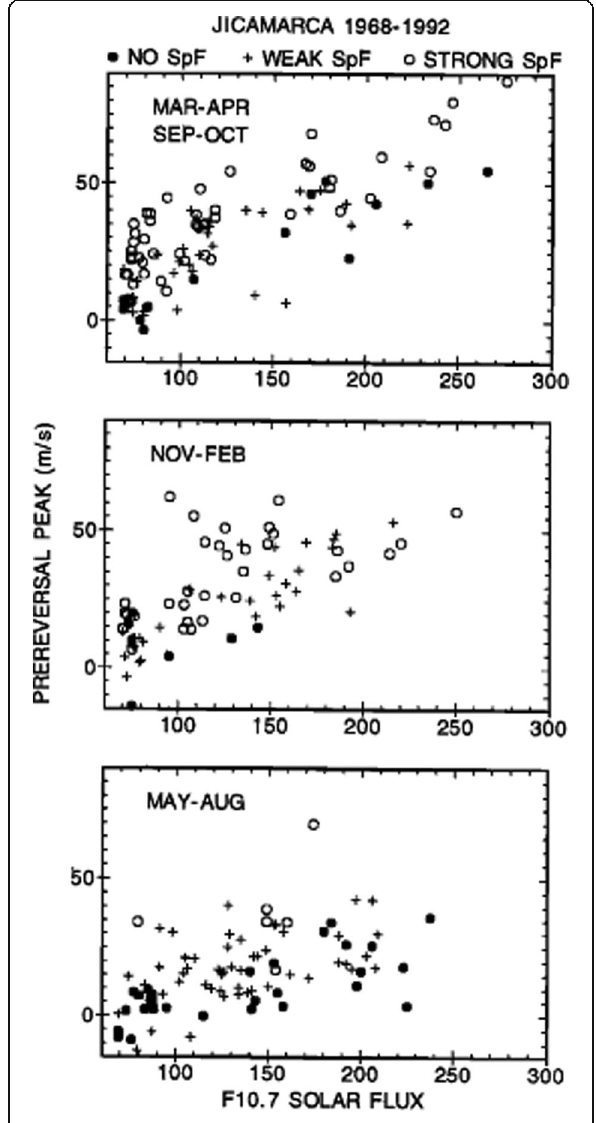
Fig. 2 Seasonal and solar cycle dependence of postsunset maximum upward drifts and spread F occurrence measured by the Jicamarca radar. Dots, plus signs, and open circles represent no spread F, weak spread F, and strong spread F events, respectively. (After Fejer et al.